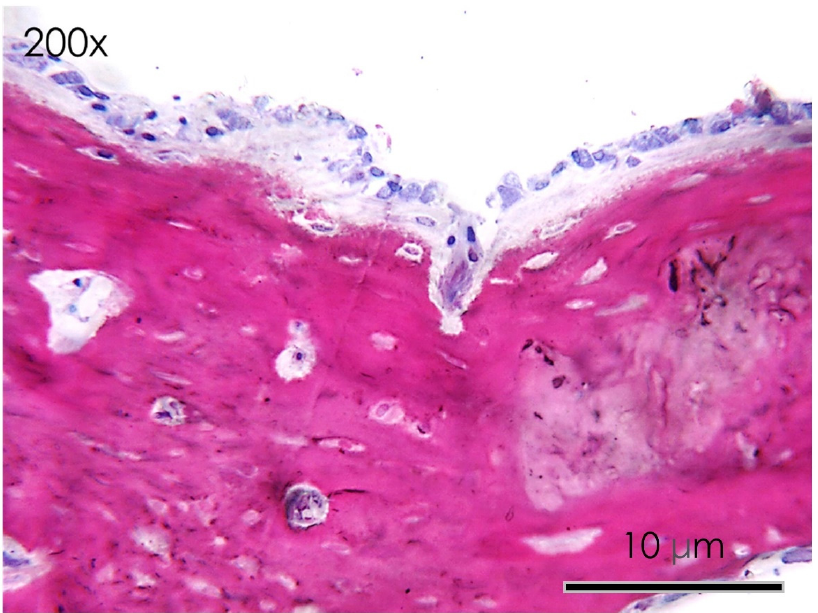
Figure 12. Curcumin group. Detail at higher magnification of the histological section of the calvaria bone specimens (200 × ). A nonorganized osteoid matrix neo-apposition was reported.